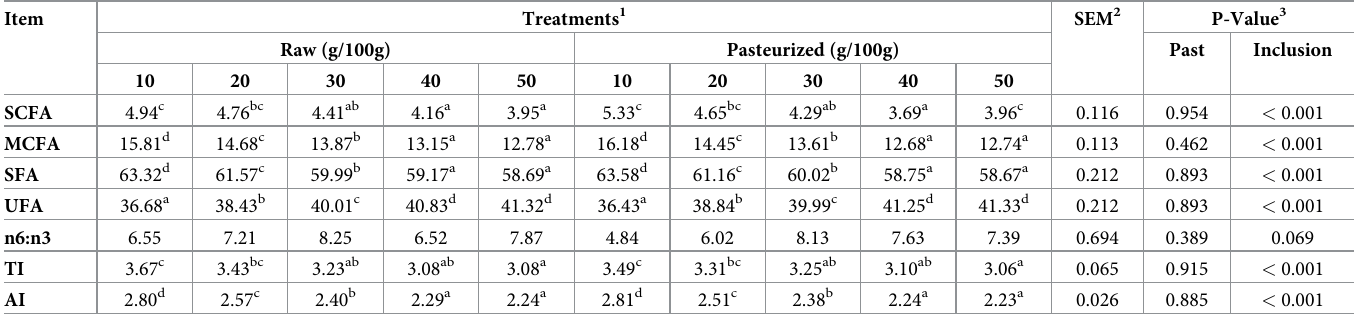
Table 4. Fatty acid groups in pasteurized and unpasteurized formulations.